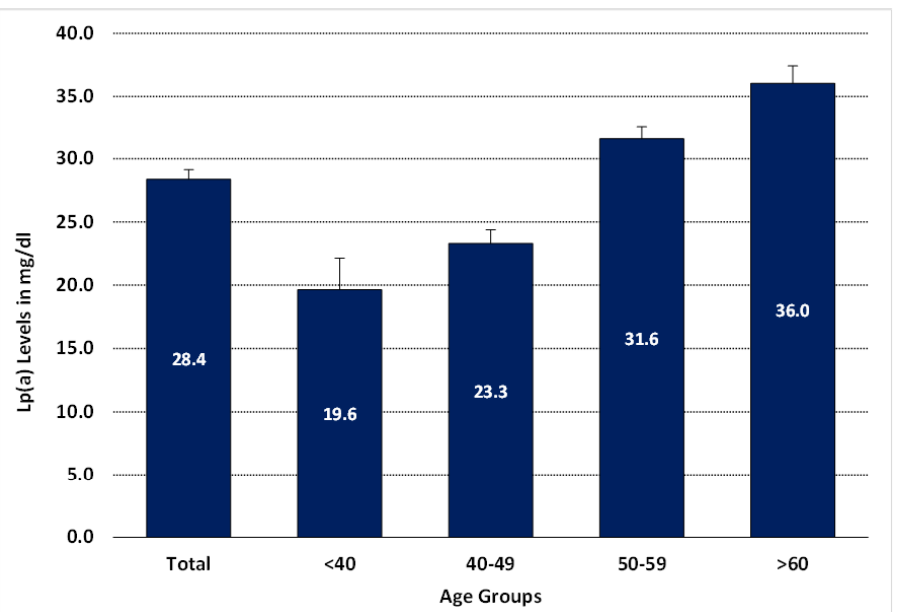
Figure 3. Comparing lipoprotein(a) levels in different age groups. Note: Data are presented as the mean of lipoprotein(a) level in mg/dL in each bar according to age groups.